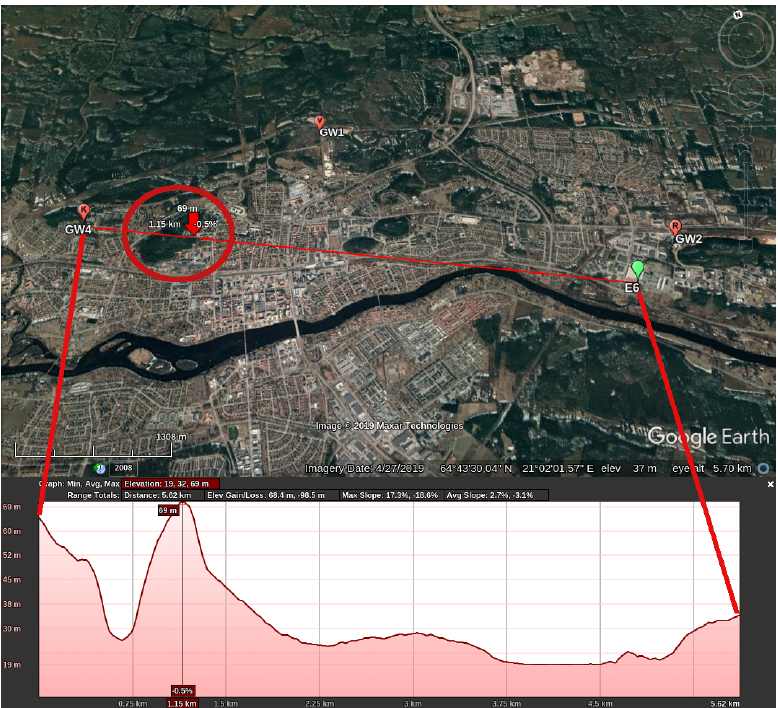
Figure 19. Elevation profile for the path between E6 and GW4 created with Google Earth